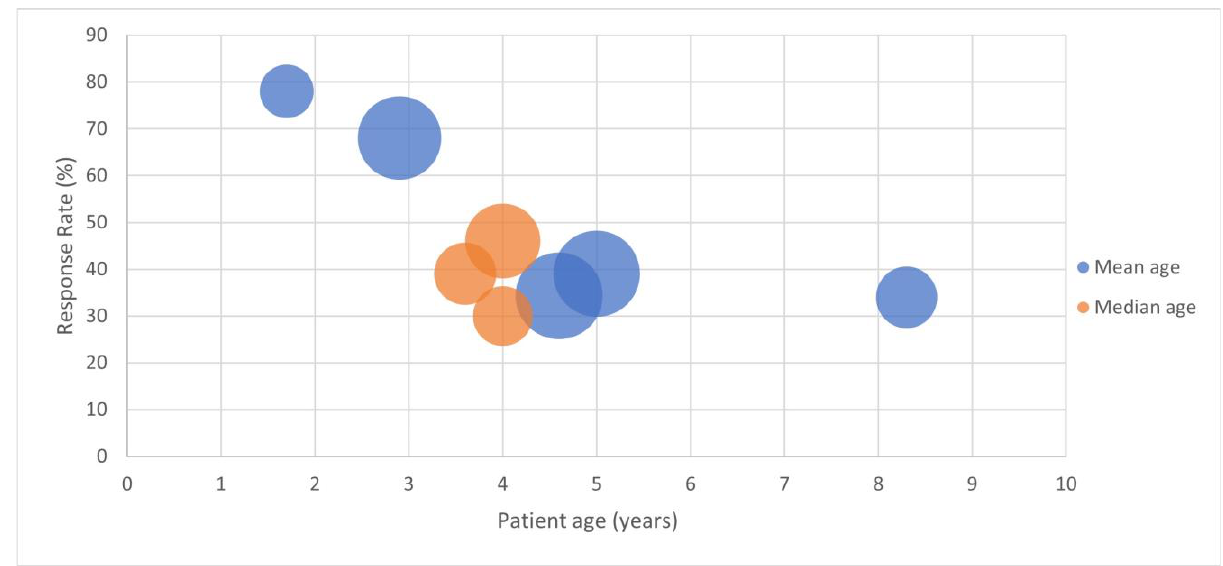
Figure 1. Response rates to CMP elimination diet and challenge in children with constipation, according to age of study participants, showing higher response rates in younger patients. Y axis indicates response to diet as a percentage. X axis indicates age of study participants in years, by measures of central tendency (mean age in blue or median age in orange). Bubble size indicates number of participants. Study details are in Table 1 above.